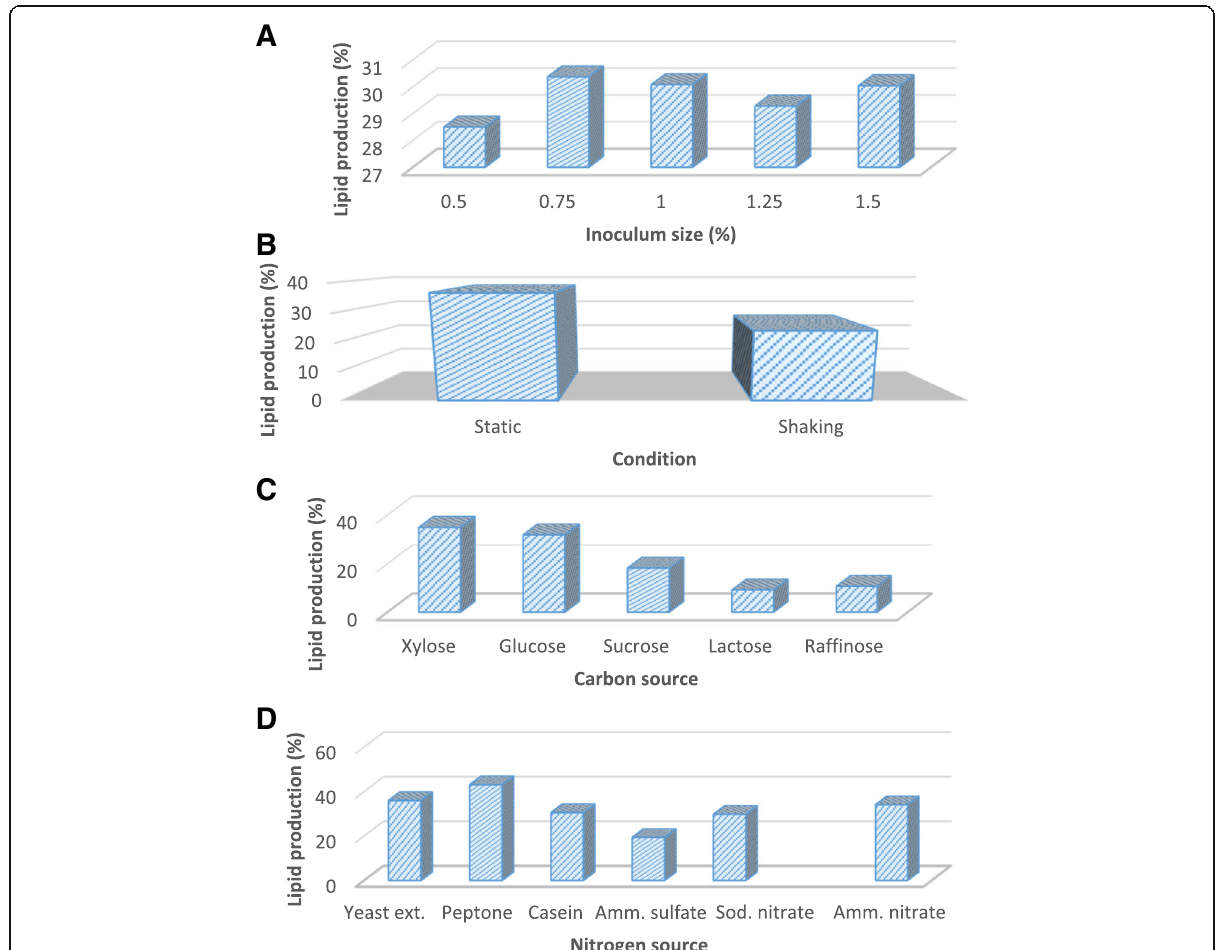
Fig. 2 Effect of inoculum size ( a ), static and shaking conditions ( b ), different carbon sources ( c ), and different nitrogen sources ( d ) on P. commune